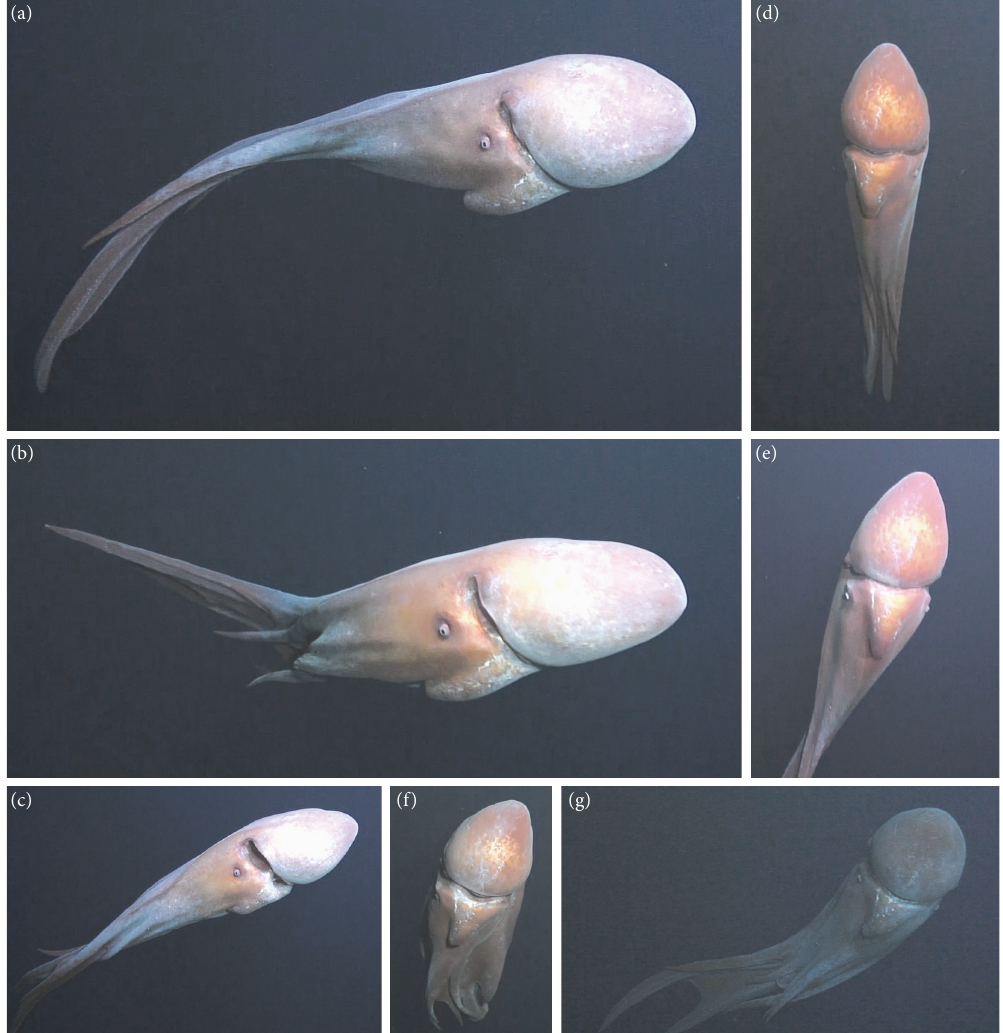
Figure 3: Video frame-captures of a gelatinous giant octopod, Haliphron atlanticus , that was video-recorded in front of the Shinkai 6500 submersible at about 586–599 m along the West Mariana Ridge in May 2017 showing various different postures and orientations near the end of the encounter (a) 12:24:22, 589 m, (b) 12:24:26, 588 m, and (c) 12:24:18, 589 m, and earlier in the encounter (d) 12:22:20, 598 m, (e) 12:22:32, 598 m, (f) 12:23:37, 591m, and (g) 12:23:18, 594